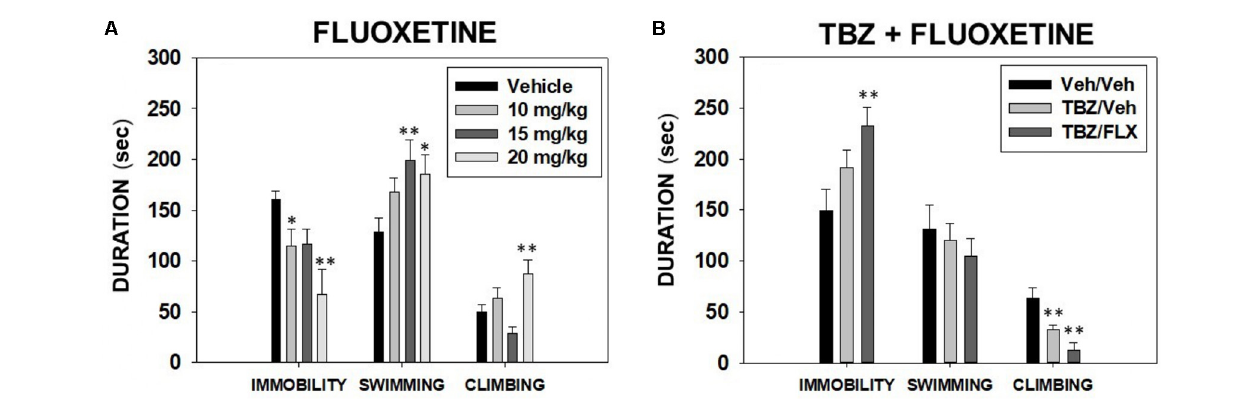
FIGURE 1 | Effect of fluoxetine (Vehicle, 10, 15 or 20 mg/kg) (A) and tetrabenazine (TBZ) plus fluoxetine combination (Veh + Veh, TBZ + Veh, or TBZ + Fluoxetine 20 mg/kg (B) on the duration of immobility, swimming, and climbing behavior in the forced swim test (FST) assessed for 6 min. Groups were analyzed using one-way analysis of variance (ANOVA) for independent samples in each dependent variable. Bars represent mean ± SEM of accumulated seconds. ∗ p < 0.05, ∗∗ p < 0.01 significantly different from the control group.